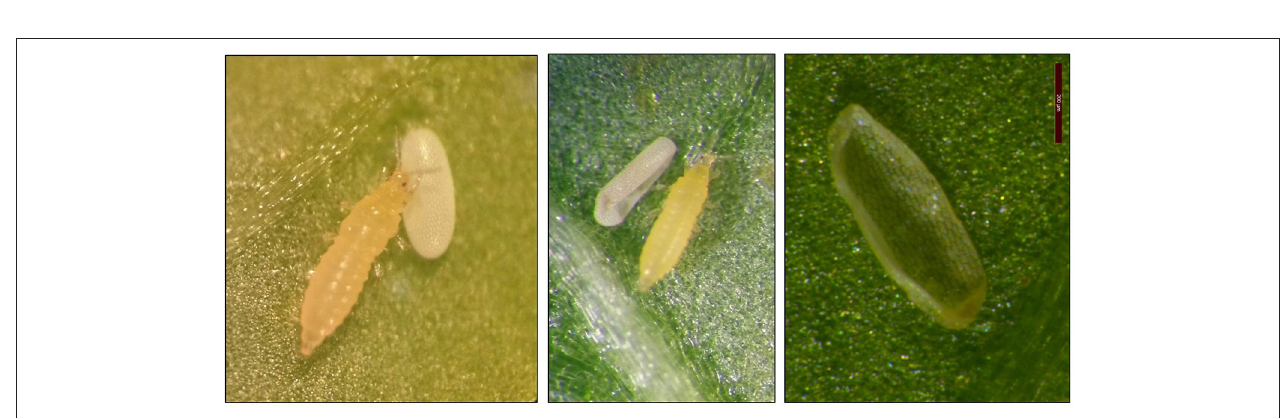
FIGURE 5 | Direct effects of the presence of thrips on syrphid performance. (A) S. rueppellii eggs damaged by prey in a Petri dish experiment; (B) S. rueppellii larval survival after prey presence in a Petri dish experiment; (C) S. rueppellii eggs damaged by larvae vs. adults thrips on entire plants and (D) S. rueppellii larval survival in the presence of second instar larvae and adults thrips on entire plants. Bars represent means ± SE ( n = 20 replicates). Asterisks indicate significant differences between infestation treatments: *** P < 0.001, * P < 0.05 and n.s not significant differences ( P > 0.05, GLM).